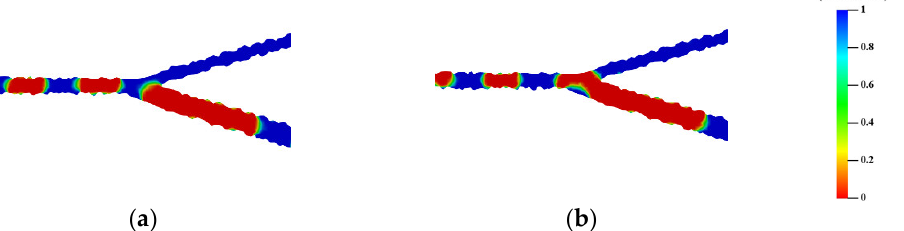
Figure 18. Snapshots of the phase distribution for the Y-shaped junction models with flow rates of ( a ) 0.0002 m/s; ( b ) 0.004 m/s.